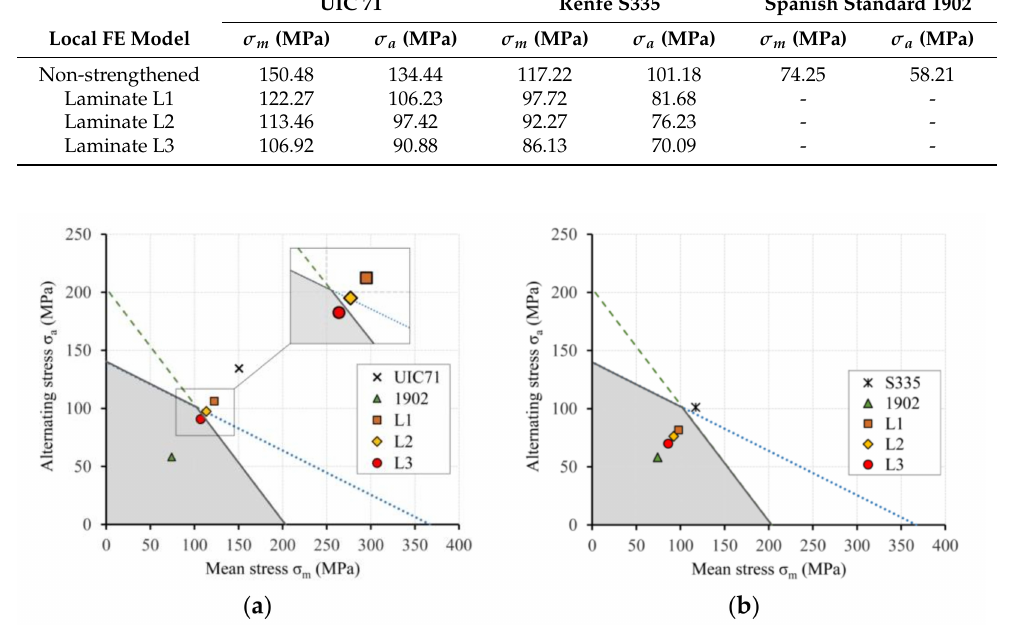
Figure 20. Constant fatigue-life diagrams (CLD) for local FE model results. ( a ) UIC 71. ( b ) S335.